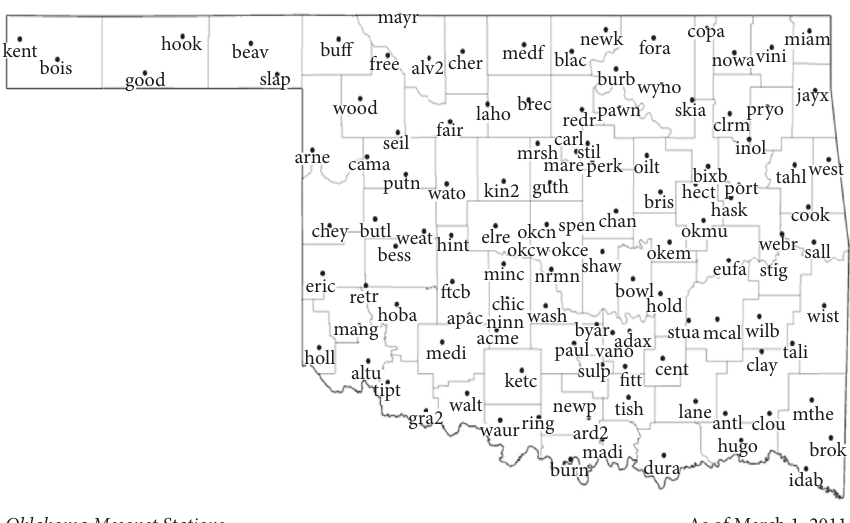
Figure 1: The Oklahoma Mesonet: stations displayed as of March 1,